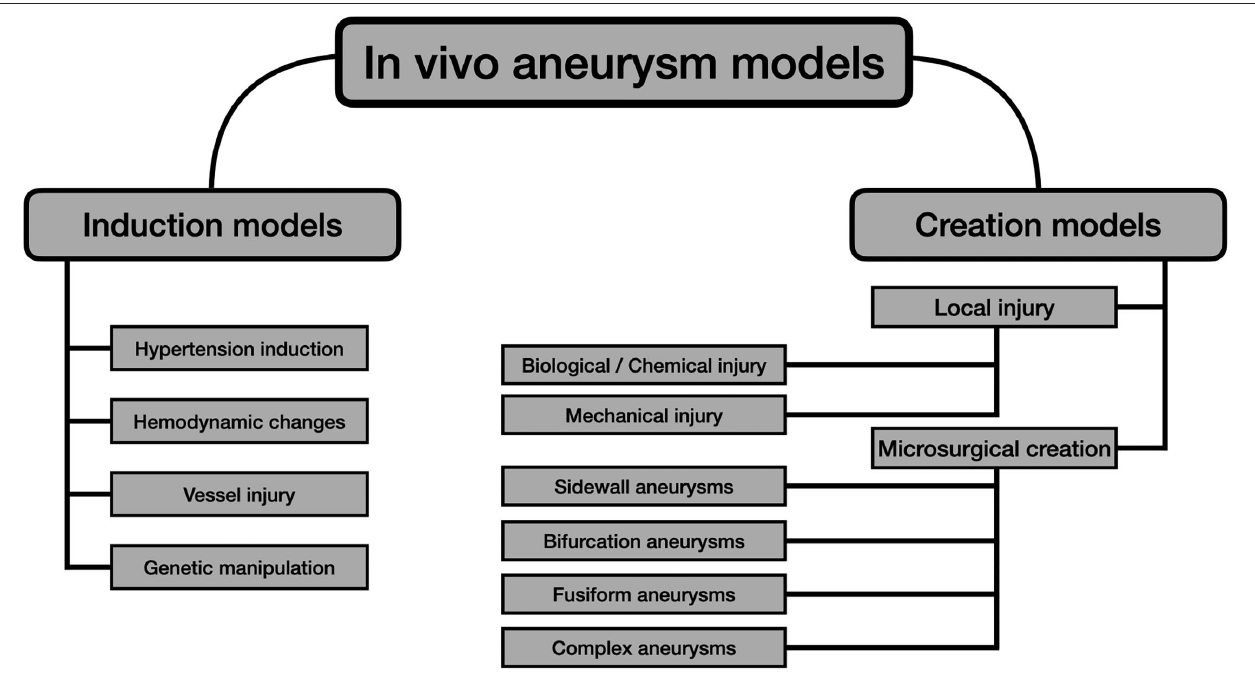
FIGURE 1 | Diagram showing the most common experimental in vivo models for